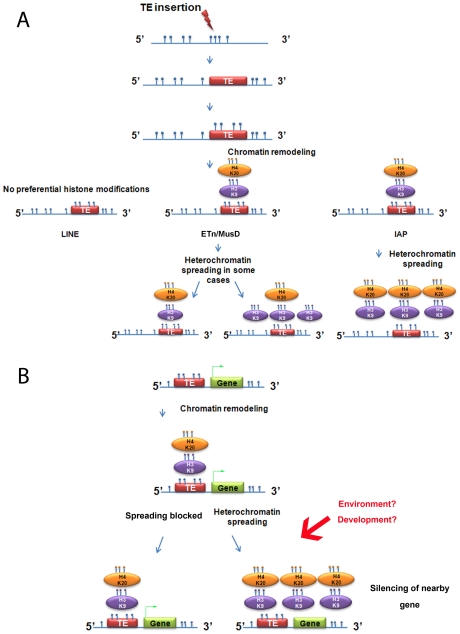
Summary of heterochromatin spreading due to transposable elements in mouse ES cell lines.A. Summary of the data obtained with the insertionally polymorphic families LINE, ETn/MusD and IAP. H4K20me3 on ETn/MusD was shown by Mikkelsen et al. [12]. B. Possible consequences of IAPs or ETn/MusDs near a gene. Blue circles represent methyl groups; if present directly on the DNA molecule they illustrate DNA methylation and if on an oval, a histone methylation. The green arrow on the gene represents transcription.